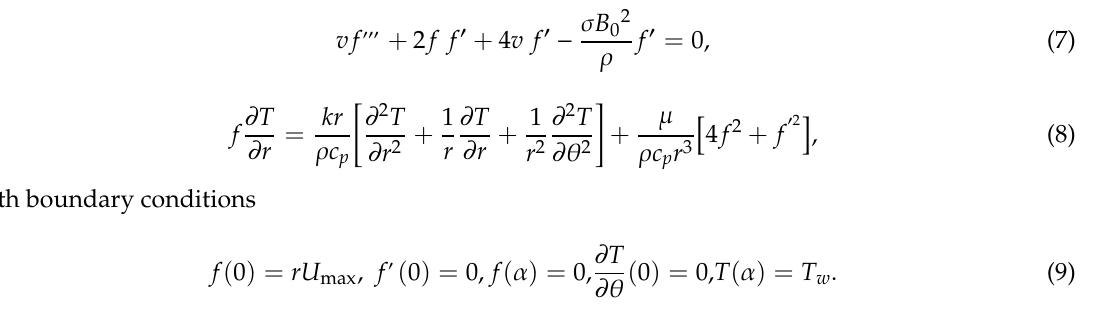
Figure 2. Variation of G(y) in diverging channel for Re = 40, 80, 120, 160 and 0